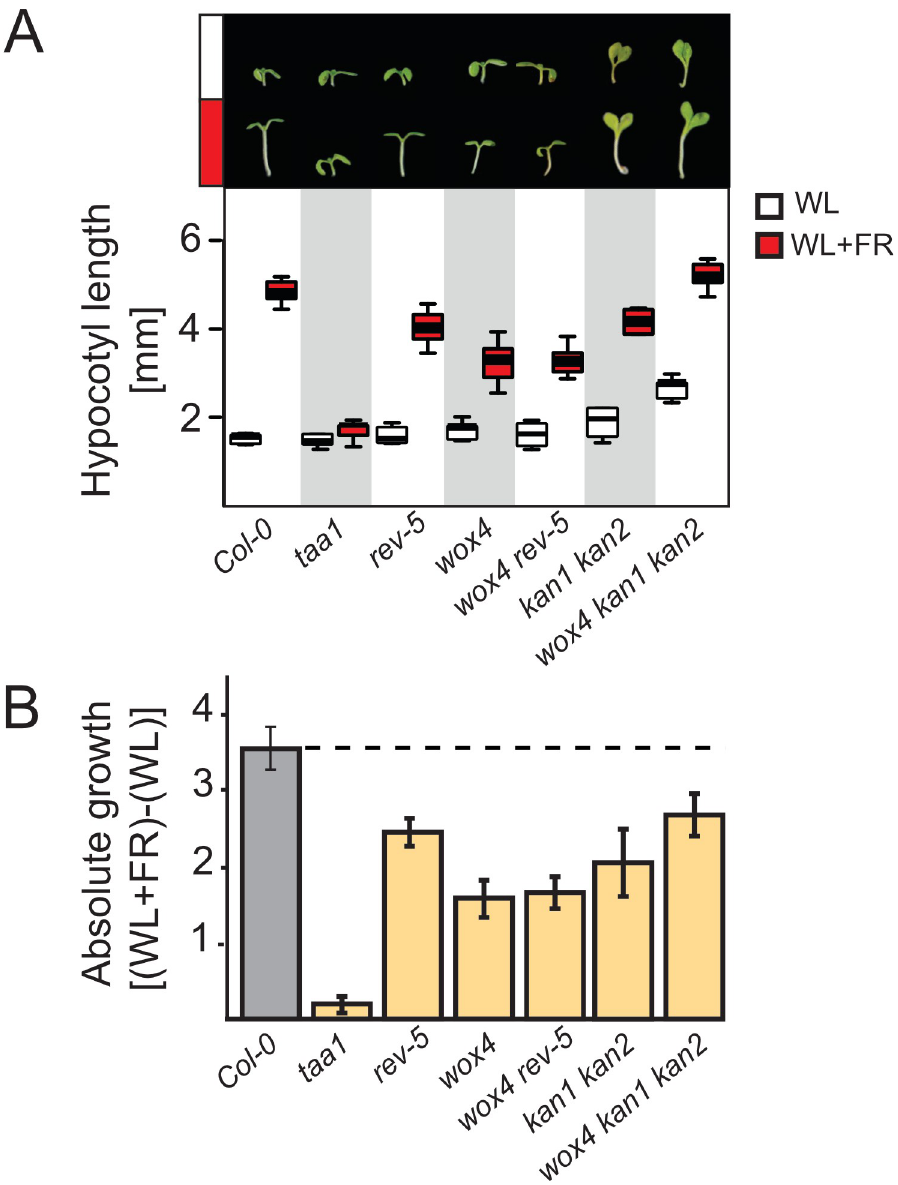
Fig 2. Mutants affecting vascular patterning show altered shade avoidance hypocotyl responses. A , Hypocotyl lengths of wild type Col-0 and an array of mutant seedlings in white light (WL) and far-red enriched white light (WL +FR) conditions. The upper panel depicts representative seedlings. Box plots below show the observed experimental data; white boxes hypocotyls grown in WL; red boxes, hypocotyls grown in WL+FR. B , Absolute hypocotyl expansion by subtracting the length in WL from the length in